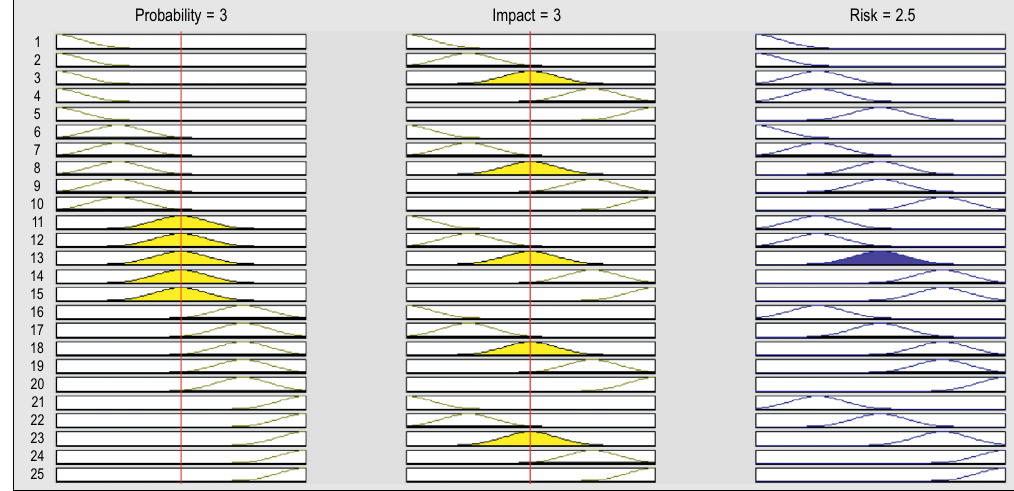
Fig. 9. Sample of rules